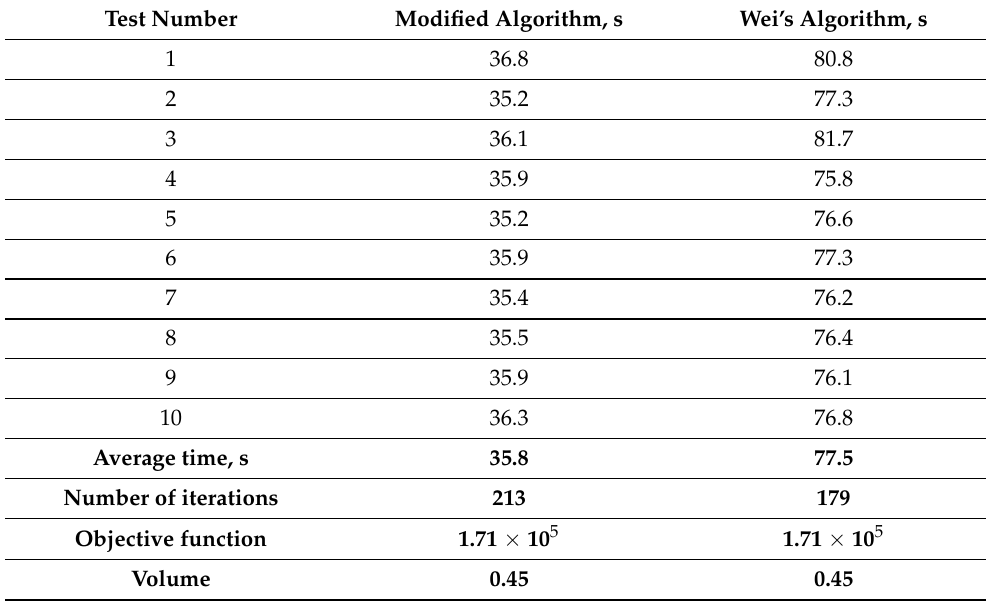
Table 1. Results of algorithms comparison.